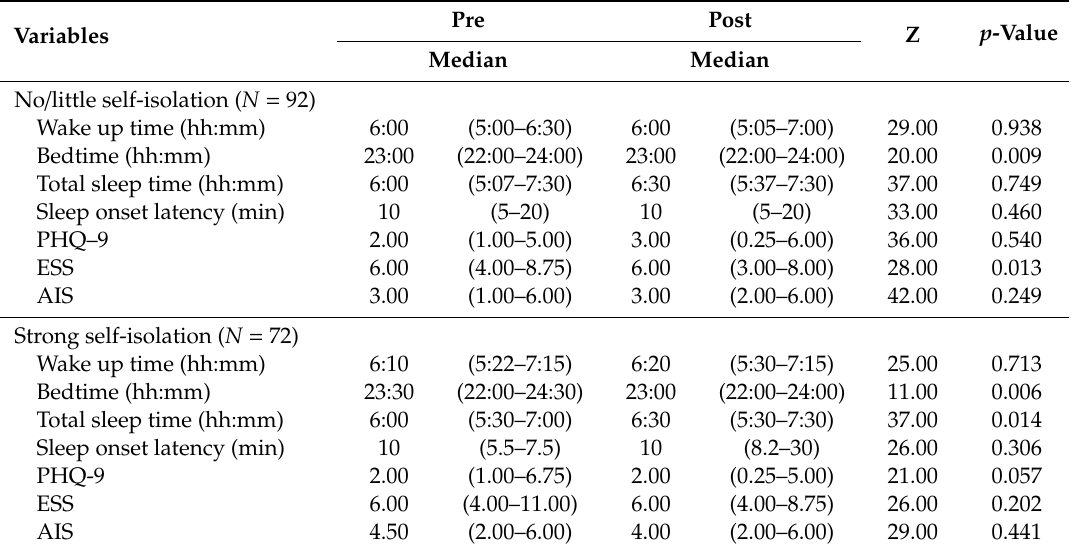
Table 1. Result of Wilcoxon signed-rank test on sleep habits and Patient Health Questionnaire-9 (PHQ-9), Athens Insomnia Scale (AIS), and Epworth Sleepiness Scale (ESS). Variables